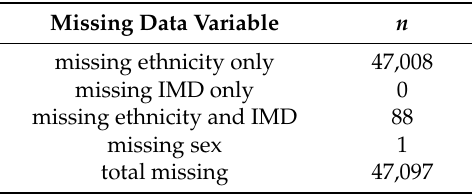
Table 2. Missing data preventing risk score calculation.